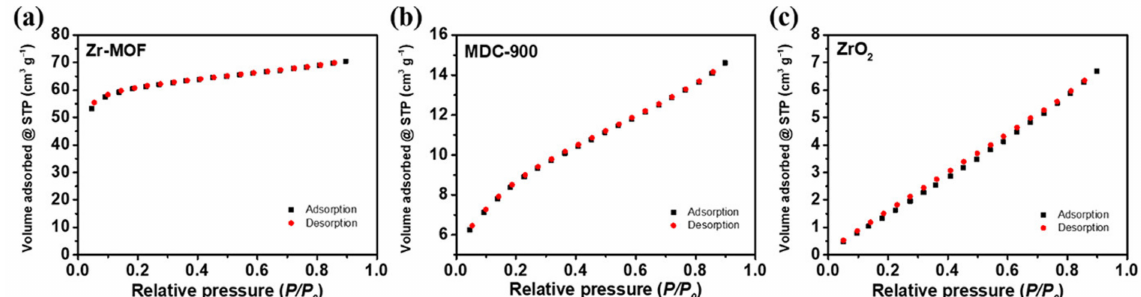
Figure 4. BET nitrogen adsorption and desorption curves of ( a ) Zr-MOF, ( b ) MDC-900, and (c) ZrO 2 .